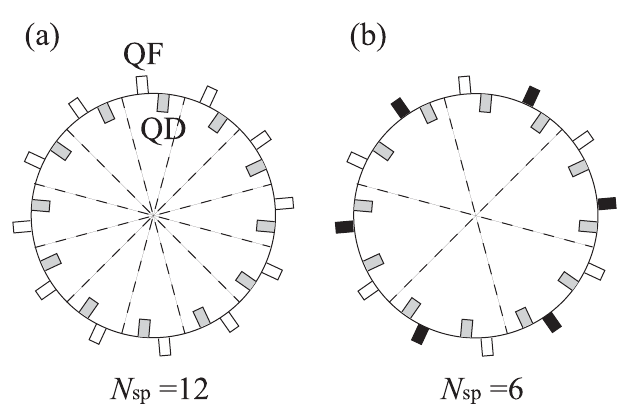
(cid:2) 12 and sp